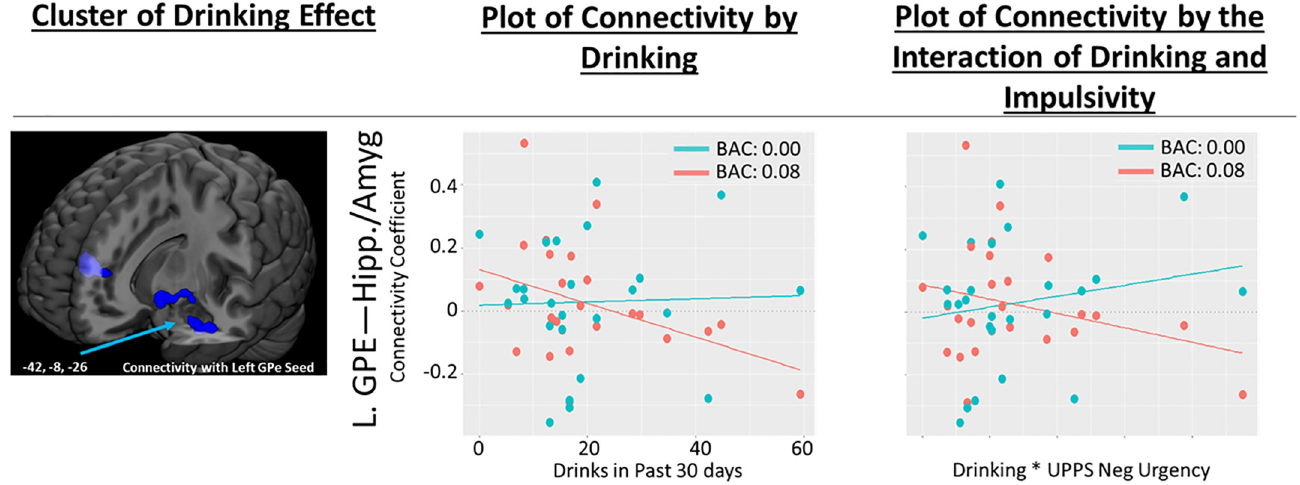
Fig 3. Effect of alcohol induced changes in GPe connectivity on the association between drinking and impulsivity. (As measured by the Alcohol Timeline Followback and UPPS-P, respectively). Cluster of Drinking Effect column: Brain images represent whole brain effects of drinks in past 30 days on alcohol induced change in functional connectivity (post-infusion connectivity > post-infusion connectivity). Warm colors indicate intoxication related increases in connectivity. Images shown at p < 0.005. Plots of Connectivity are scatter plots corresponding to individual connectivity at baseline in teal (estimated BAC: 0.0) and after infusion in salmon (BAC: 0.08); linear fit lines are also displayed for each timepoint. The y-axis for both plots is the same; the x-axis reflects the number of drinks in the last 30 days (center plot) and the number of drinks in the last 30 days multiplied by impulsivity score on the UPPS Negative Urgency scale (right plot). Abbreviations as follows: L. GPe- Left Globus Pallidus externus; Hipp./Amyg- Hippocampus/Amygdala cluster.